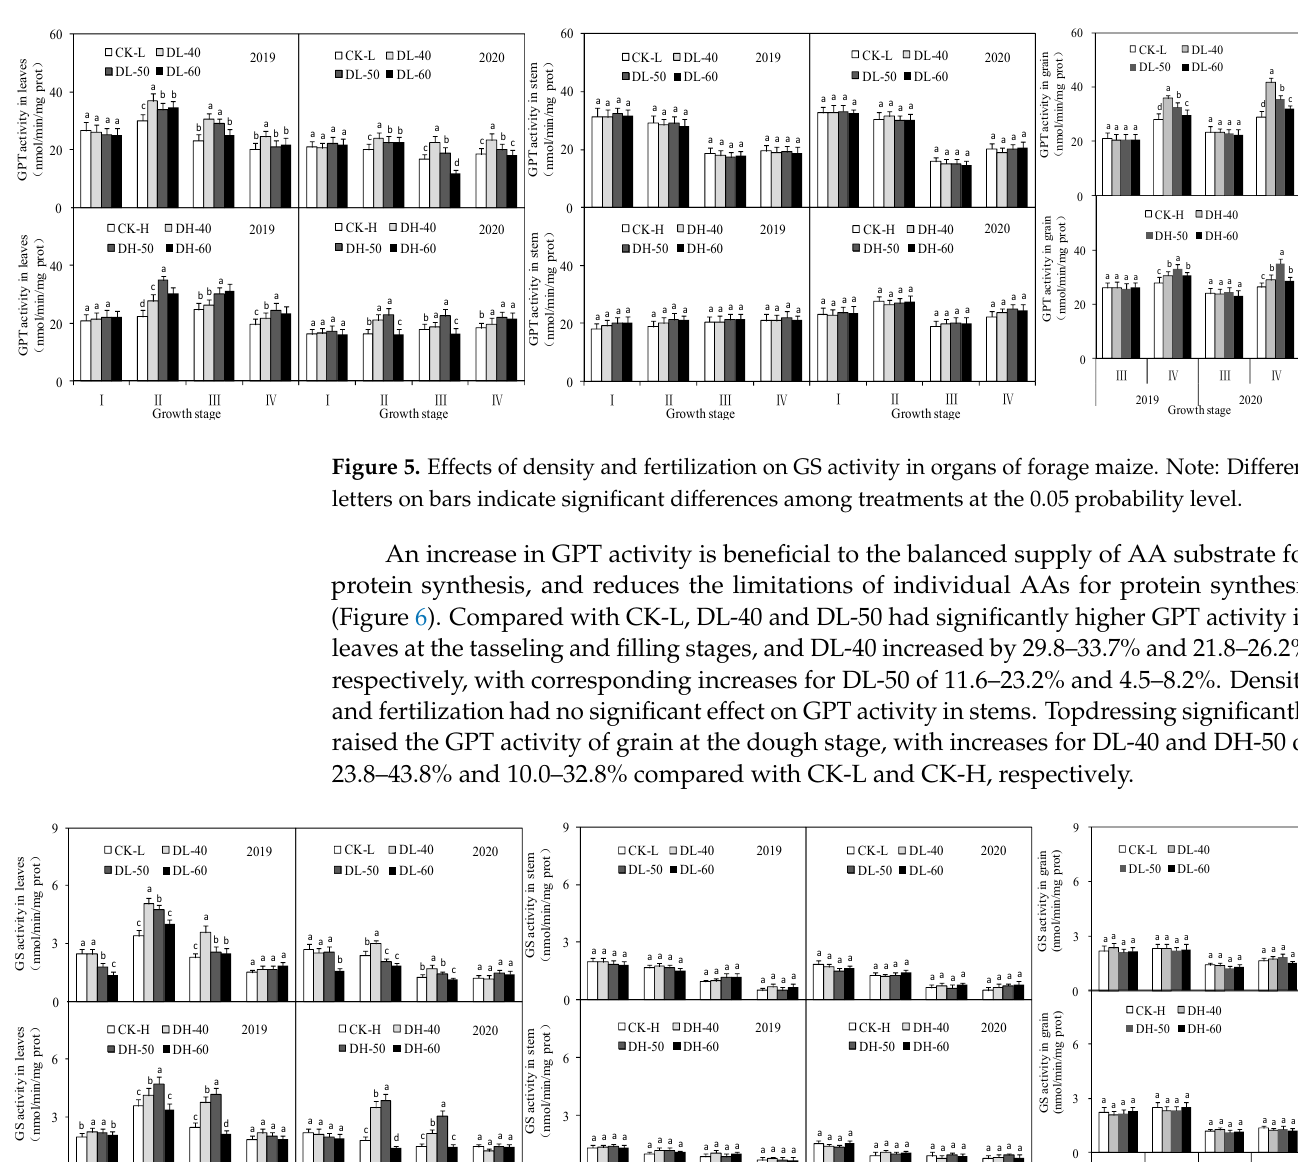
Figure 4. Effects of density and fertilization on NR activity in organs of forage maize. Note: Differ- ent letters on bars indicate significant differences among treatments at the 0.05 probability level.